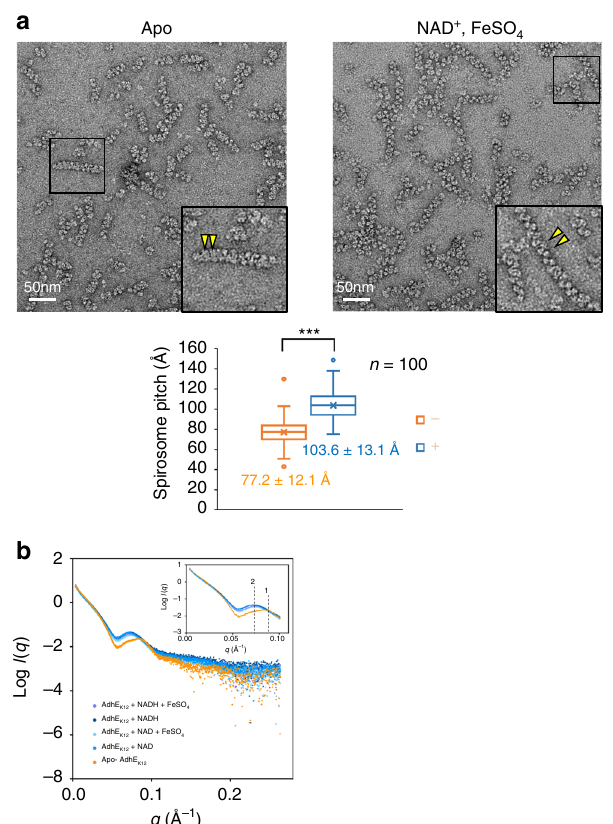
Fig. 5 AdhE spirosomes change conformation in the presence of cofactors. a Negative staining of AdhE in the absence (Apo) and the presence of NAD + and FeSO 4 . The yellow triangles indicate the positions of one pitch of the spirosome. The box plot below shows the distribution of spirosome pitch sizes in the absence (- orange, average = 77.2 ± 12.1 Å) and the presence ( + blue, average = 103.6±13.1Å) of the cofactors ( n = 100, *** p value: 4.79 ×10 – 25 ). The box includes the inter-quartile range from Q1 to Q2 and the x in the box indicates the average. The upper and lower dots indicate the maximum and minimum value respectively. b SAXS data acquired in batch mode for AdhE fraction 1 in the presence (blue) and absence (orange) of cofactors reveal conformational changes evidenced by a shift in a conserved feature from q = 0.086 Å − 1 (indicated by 1 in the inset) for Apo-AdhE to q = 0.075Å − 1 (2 in the inset) for AdhE + cofactors, which translates to 73.0 and 83.7Å in